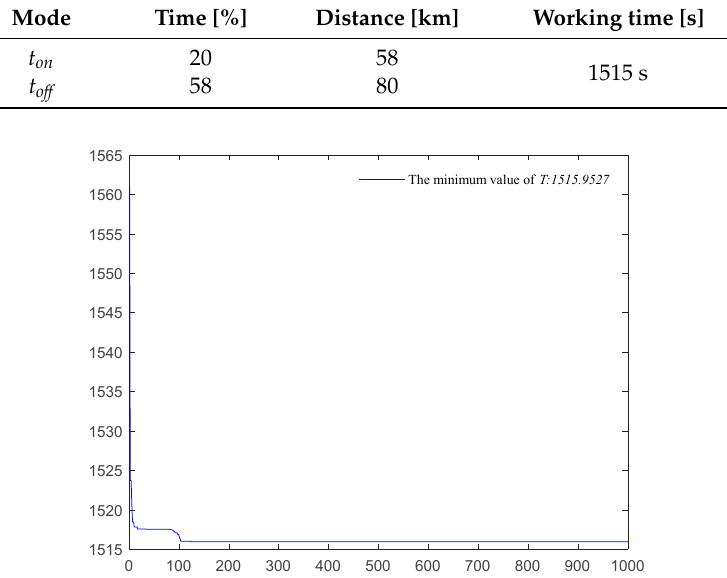
Electronics 2019 , 8 , x FOR PEER REVIEW Figure 8. Convergence curve of engine uptime optimized via BSAII. Figure 8. Convergence curve of engine uptime optimized via BSAII.